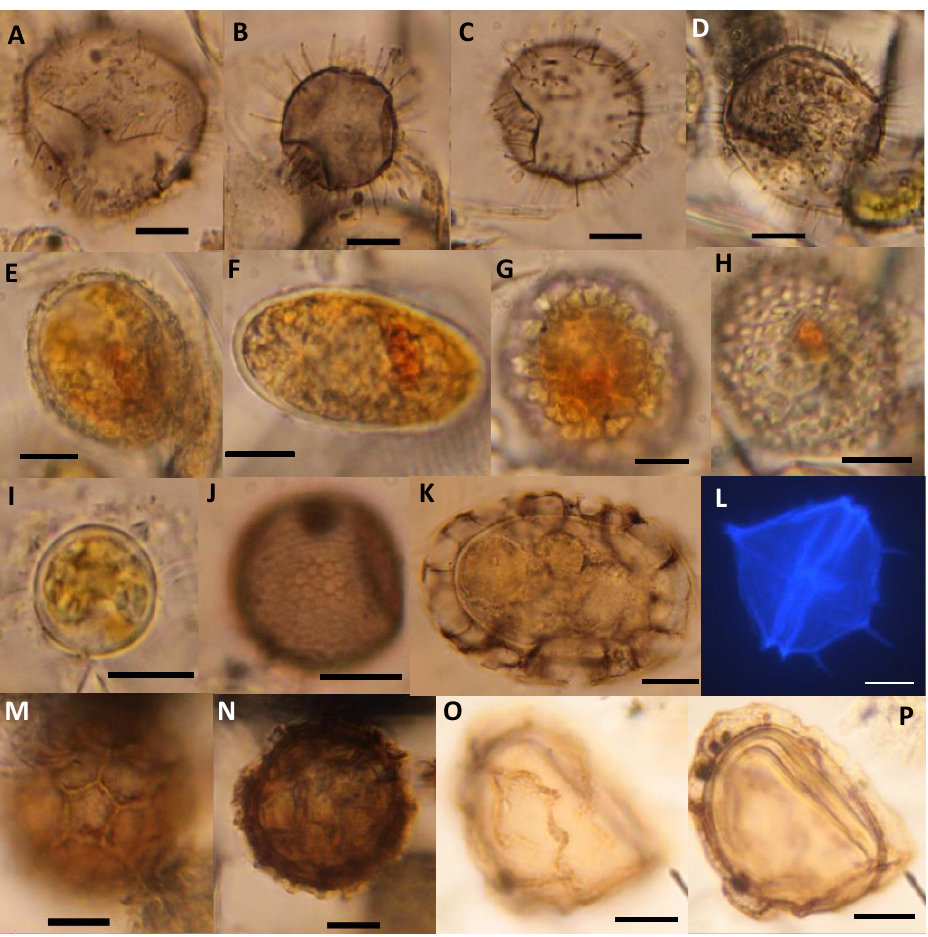
Figure 9. ( A – D ) Four examples of different spiny brown resting cysts. ( E – G ) Scrippsiella sp. resting cysts with and without crystals. ( H ) Empty Scrippsiella sp. resting cyst containing red spot. ( I ) Pen- tapharsodinium dalei resting cyst. ( J ) Gymnodinium microreticulatum resting cyst. ( K ) Polykrikos kofoidii resting cyst. ( L ) Peridinium quinquecorne vegetative cell colored with Calcofluor. ( M – P ) Two types of Margalefodinium polykrikoides resting cysts. ( M ) Type 1 surface, and ( N ) cross section. ( O ) Type 2 surface, and ( P ) cross section. The scale bars represent 10 µ